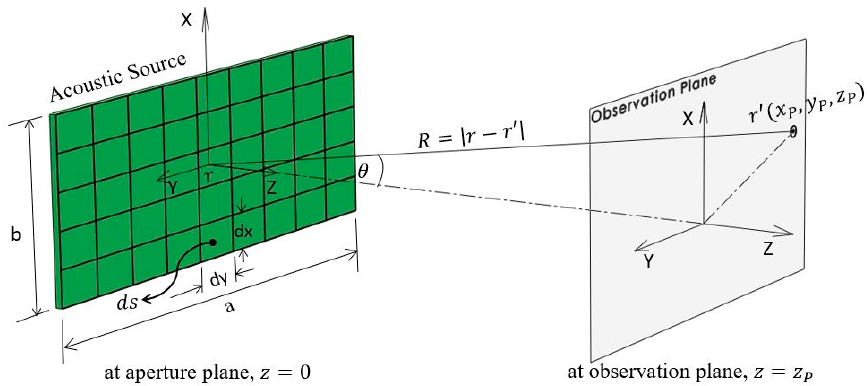
Figure 2. Rectangular transducer geometry and coordinate system for Rayleigh–Sommerfeld integral. The source pressure plane was generated at a quarter of the wavelength distance to avoid errors in the near-field, and from this source plane, parallel output pressure planes are calculated using Equation (2)